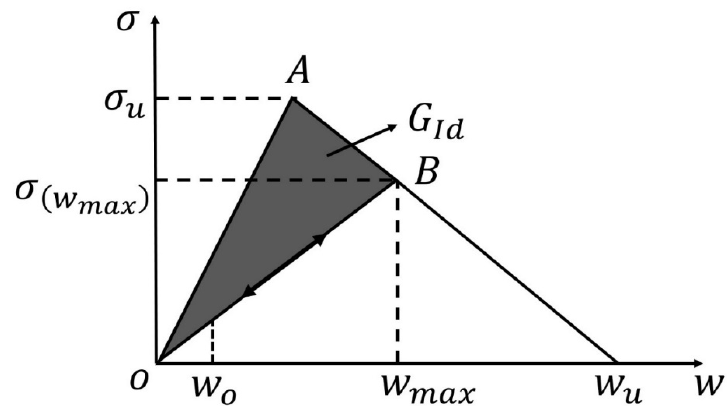
Figure 16. Schematic representation of the cohesive law [89]. Figure 17. Schematic representation of the cohesive law